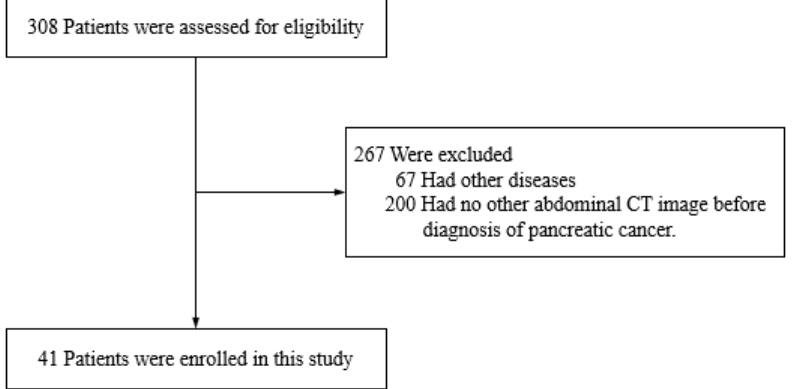
Figure 1. Enrollment.